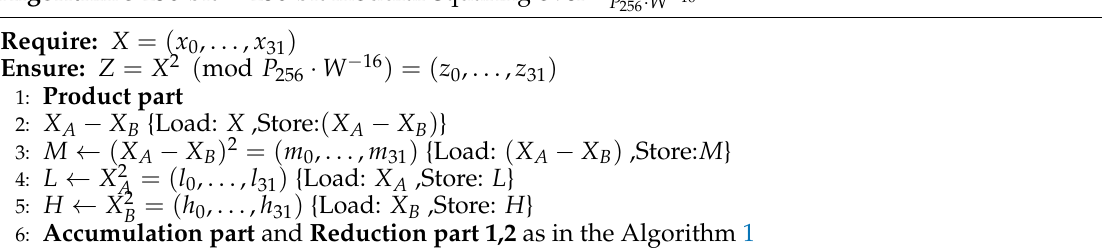
Algorithm 3 256-bit × 256-bit modular squaring over F